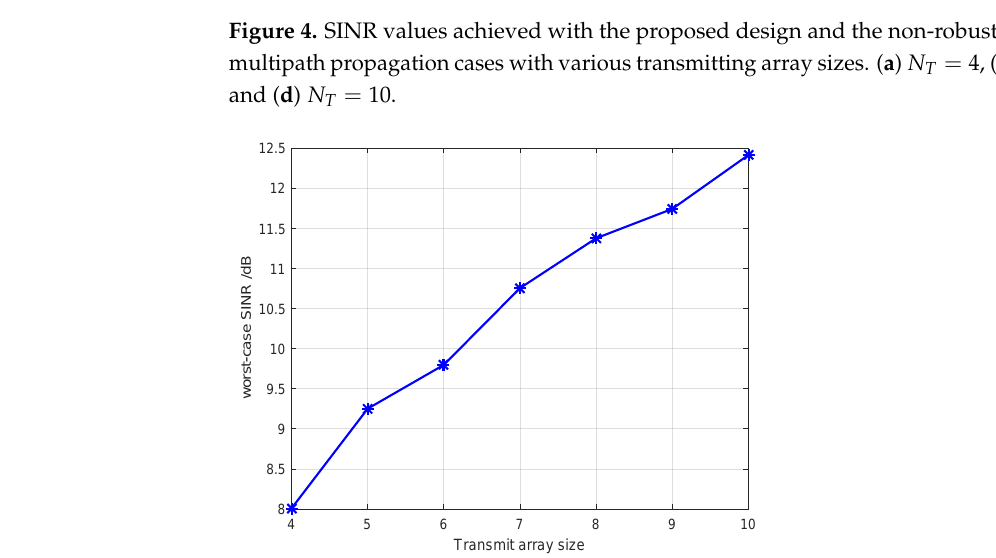
Figure 5. The worst-case output SINR provided by the proposed design versus the transmitting array